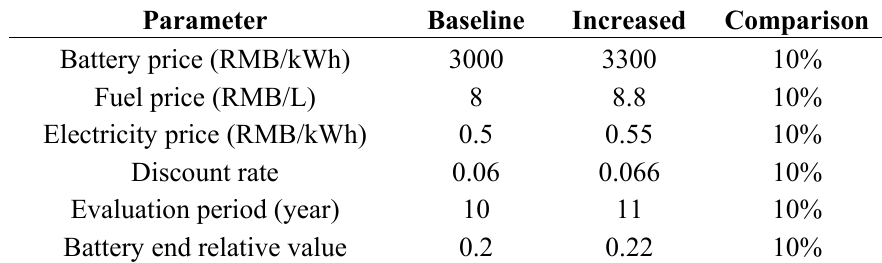
Table 3. Sensitivity analysis table.